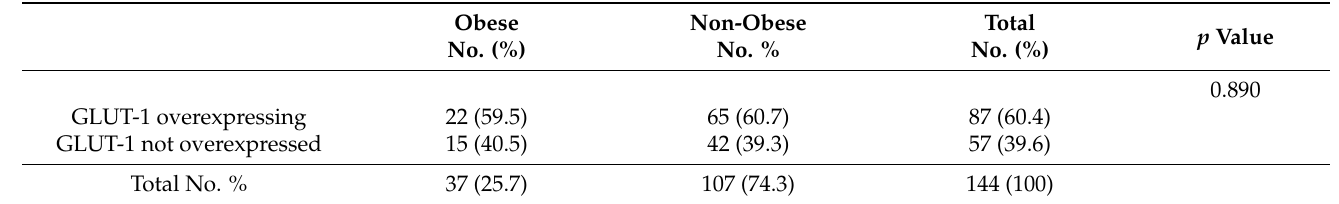
Table 10. Comparison of GLUT-1 overexpression between obese and non-obese patients regardless of diabetes